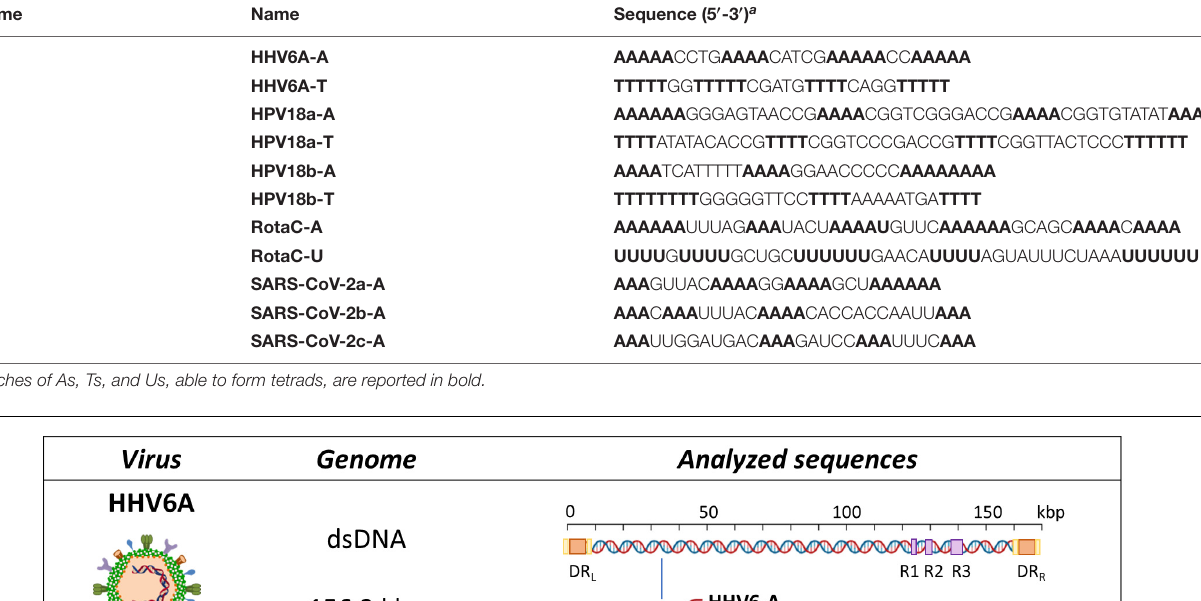
TABLE 1 | List of the selected A-rich sequences and their complementary sequences. Genome